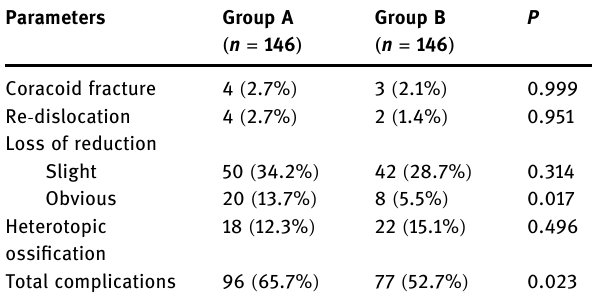
Table 5: Matched patient ’ s postoperative complications between